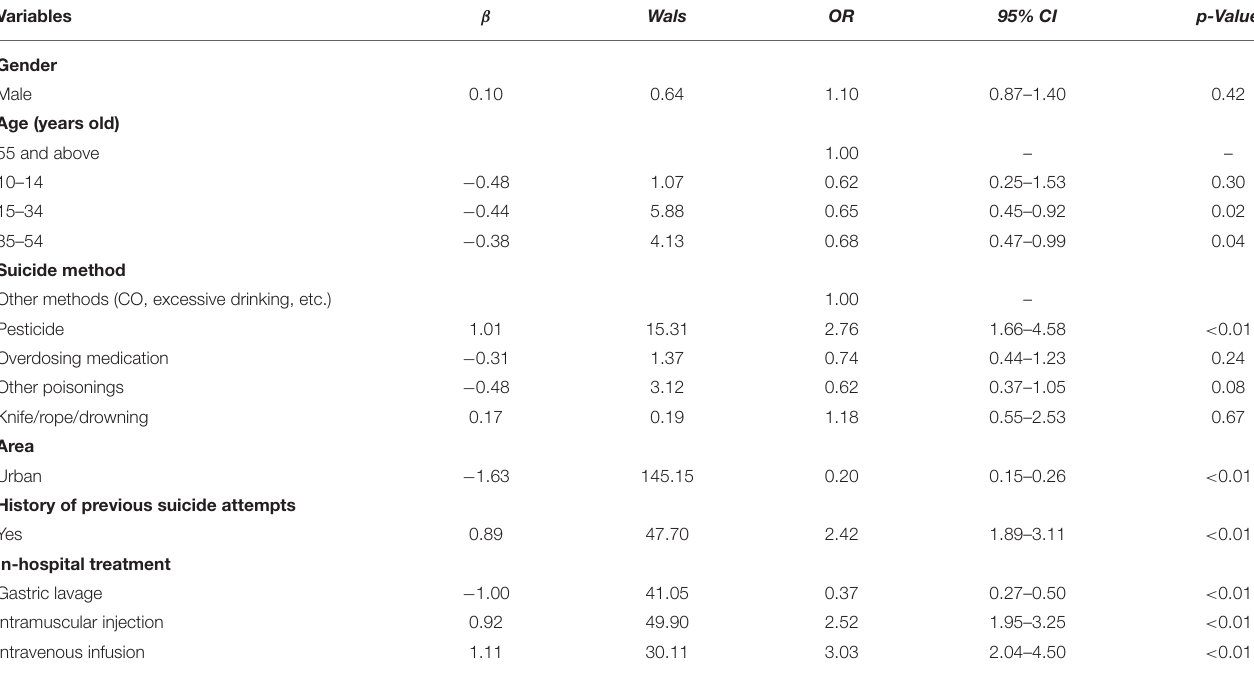
TABLE 3 | Correlates of duration of being treated in hospitals due to suicide attempts, using multivariate logistic regression analysis.